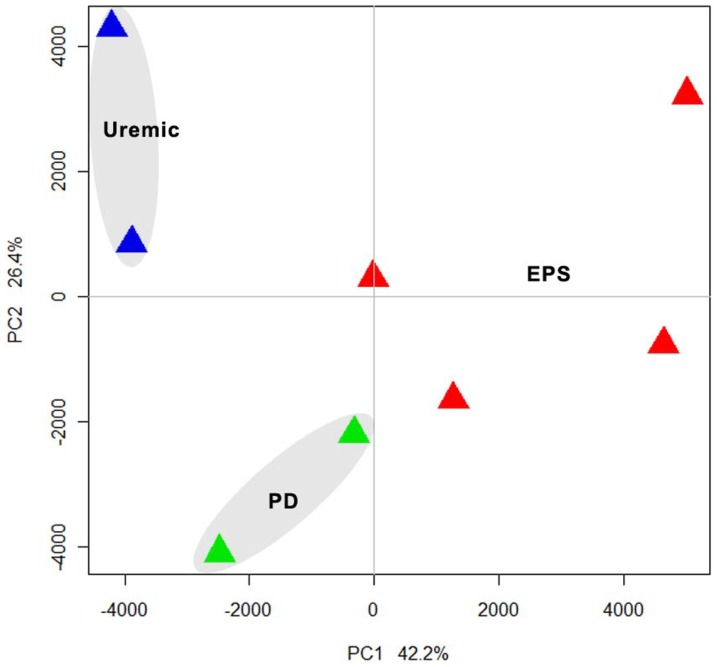
Principal Component Analysis (PCA) of normalized expression data obtained from Uremic, PD and EPS samples.The first component with highest variance (42.2%) is on the X-axis separating Uremic and PD from EPS samples. The second highest (26.4%) is on the Y-axis depicting maximum variation between PD and Uremic samples. The Uremic, PD and EPS samples formed three separate clusters on the PCA plot.